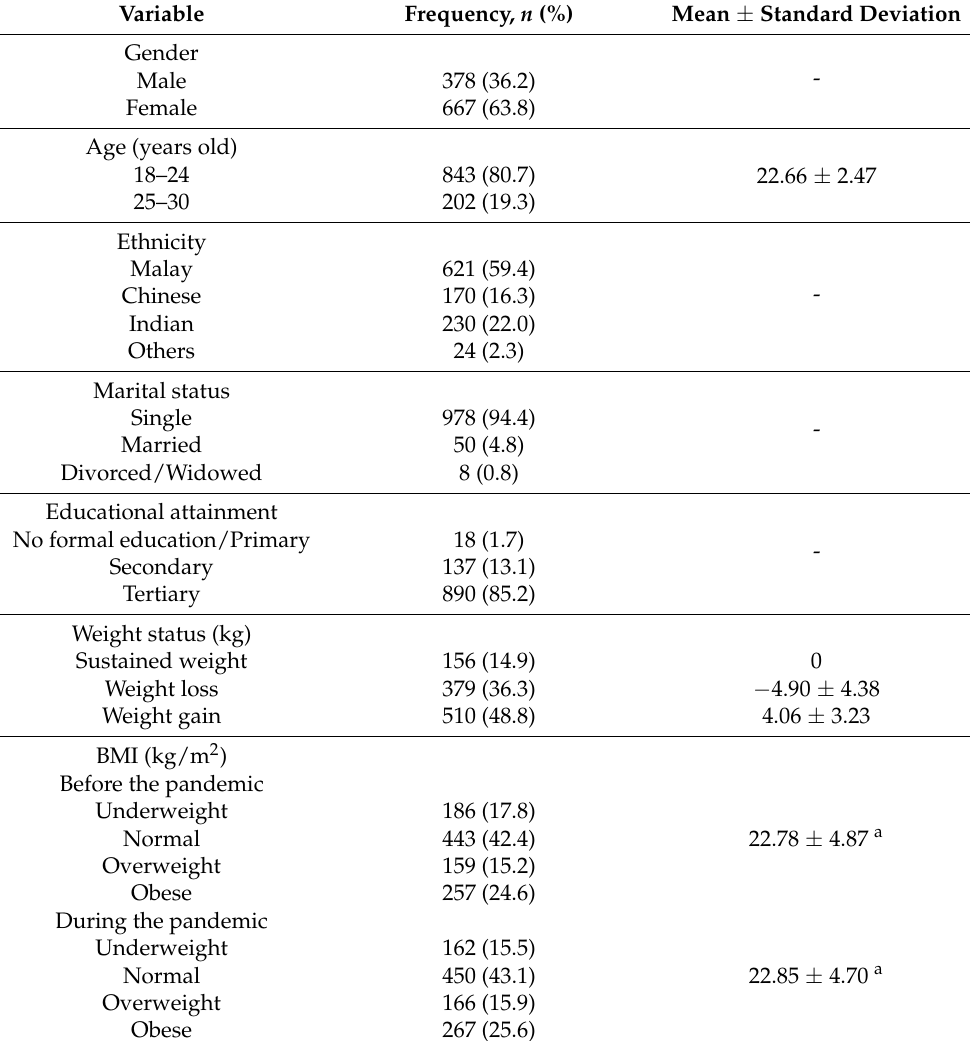
Table 1. Socio-demographic characteristics and weight status of the respondents during the COVID-19